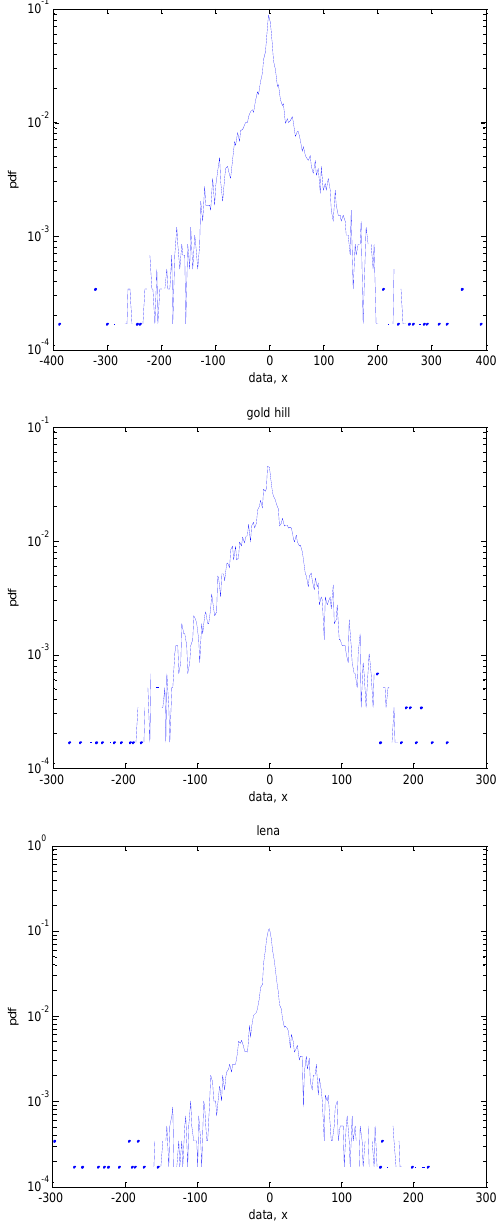
Figure 2. Histograms of horizontal sub-band of wavelet transform (one level decomposition) for three natural